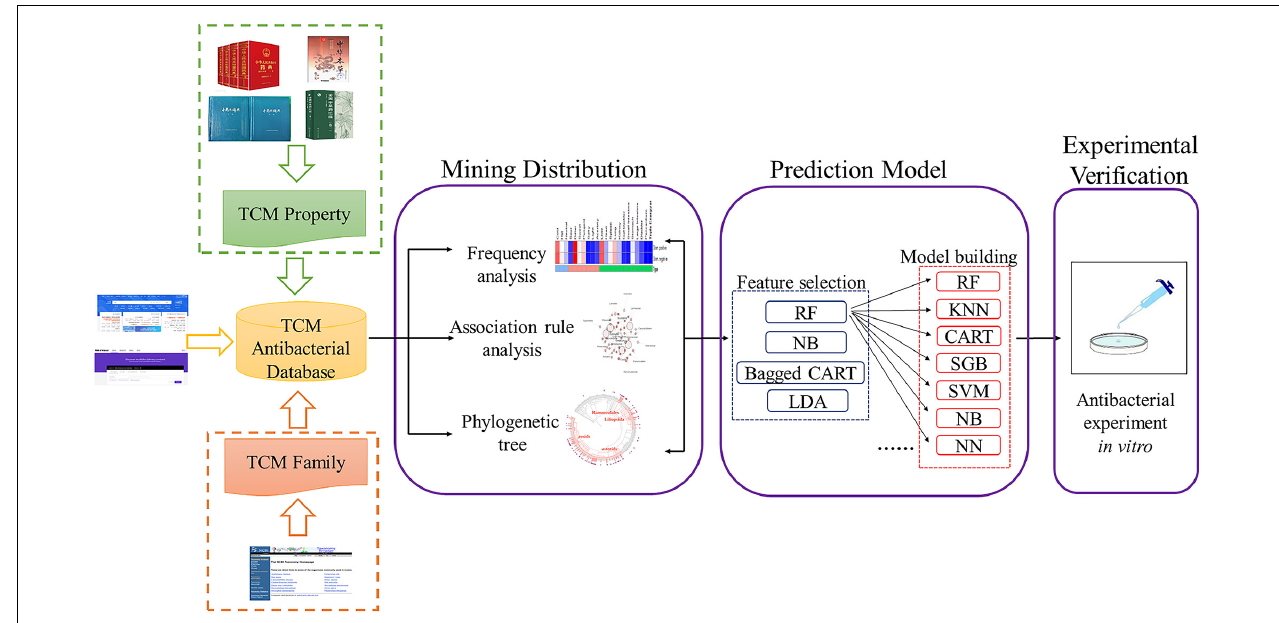
FIGURE 1 | The whole framework of this